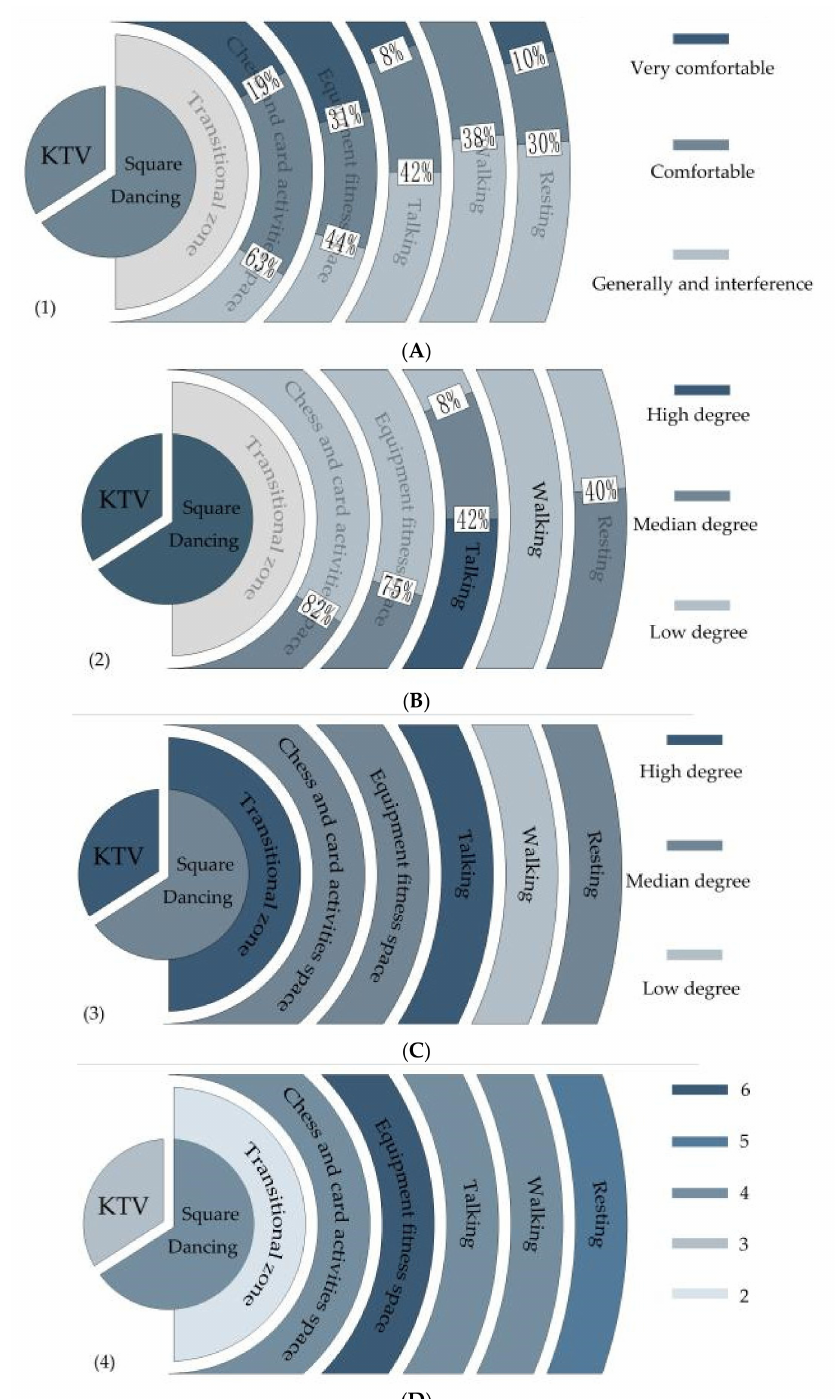
Figure 9. Idealized spatial layout model for a park. ( A ) Space layout, ( B ) degree of enclosure layout ( C ), plant density layout, and ( D ) functional degree